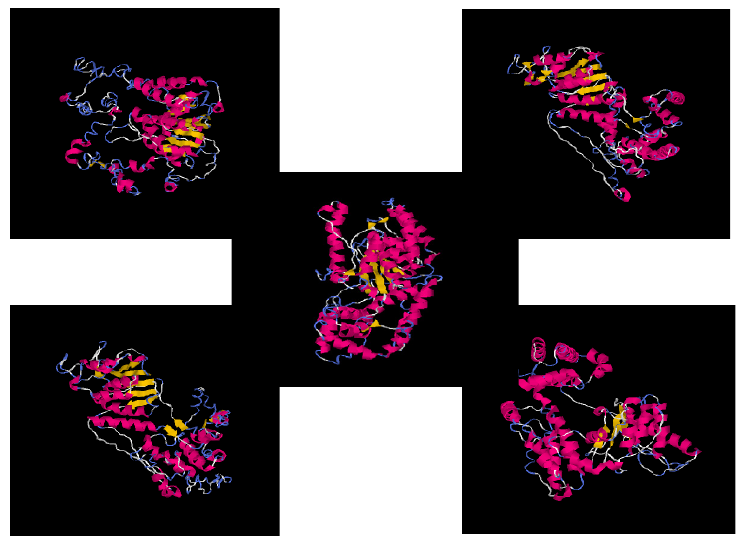
Figure 1. The Five PNPLA3 Protein Models With a Three-dimensional Structure Obtained From the I-TASSER Database According to its Amino Acid Sequence. Note . PNPLA3: Patatin-like phospholipase domain-containing 3; I-TASSER: Iterative Threading ASSEmbly Refinement.